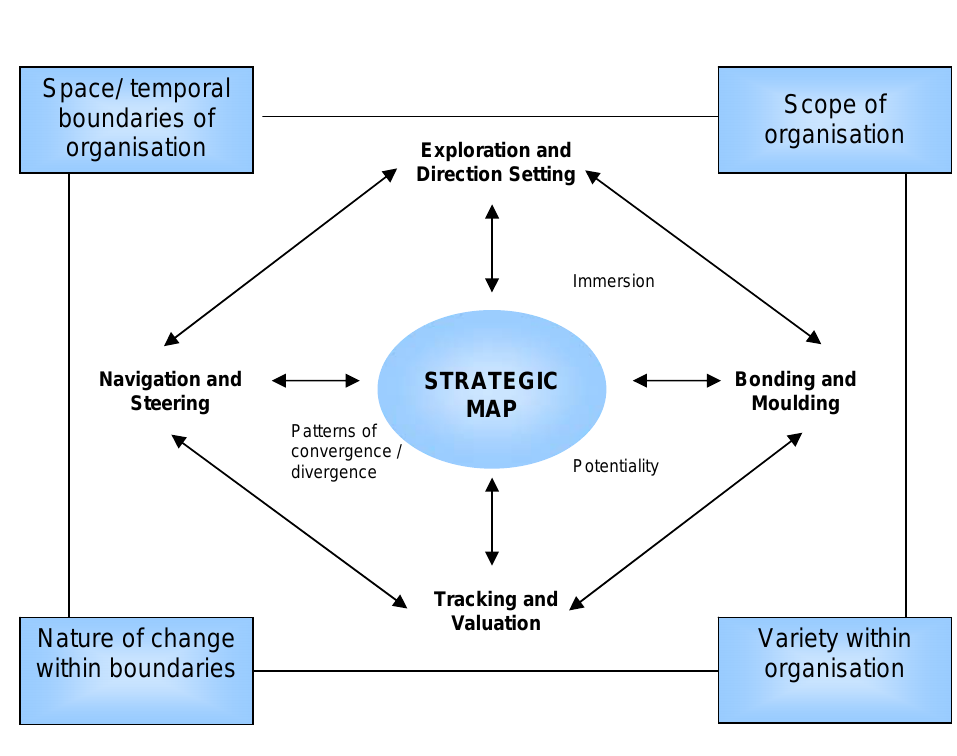
Figure 1: A full repetoire of strategising